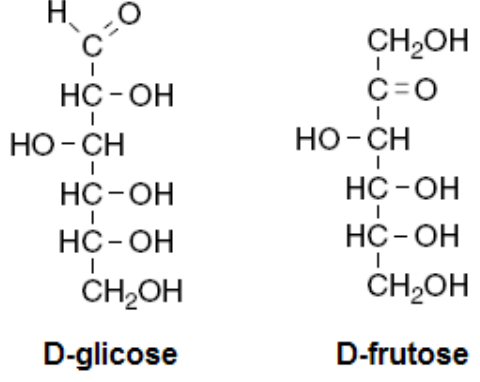
FIGURE 1 - Structural formula of D-glucose and